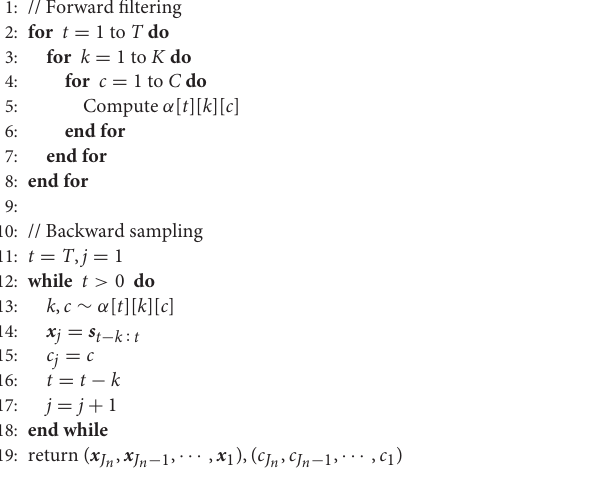
Algorithm 2 Forward filtering-backward sampling